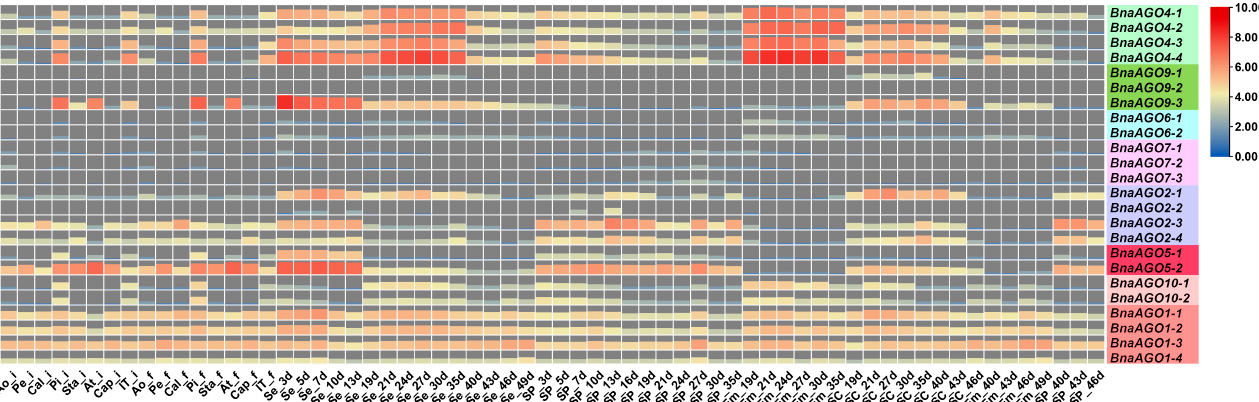
Figure 3. The conserve motif ( A ) and gene structure ( B ) analysis among the 24 BnAGOs .